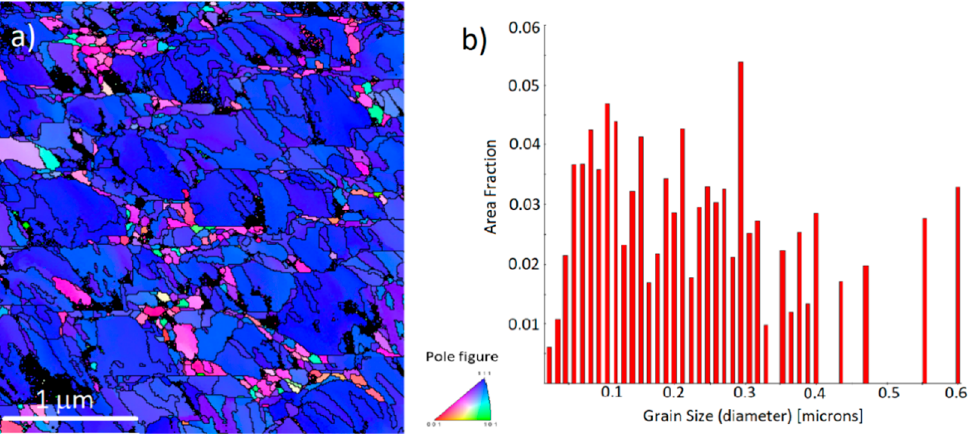
Figure 5. ( a ) Plan-view electron back-scattering diffraction (EBSD) showing surface orientation of gold films, with approx. 80% of the surface showing (111)-orientation. ( b ) Grain size distribution, with average grain size of 231 nm.